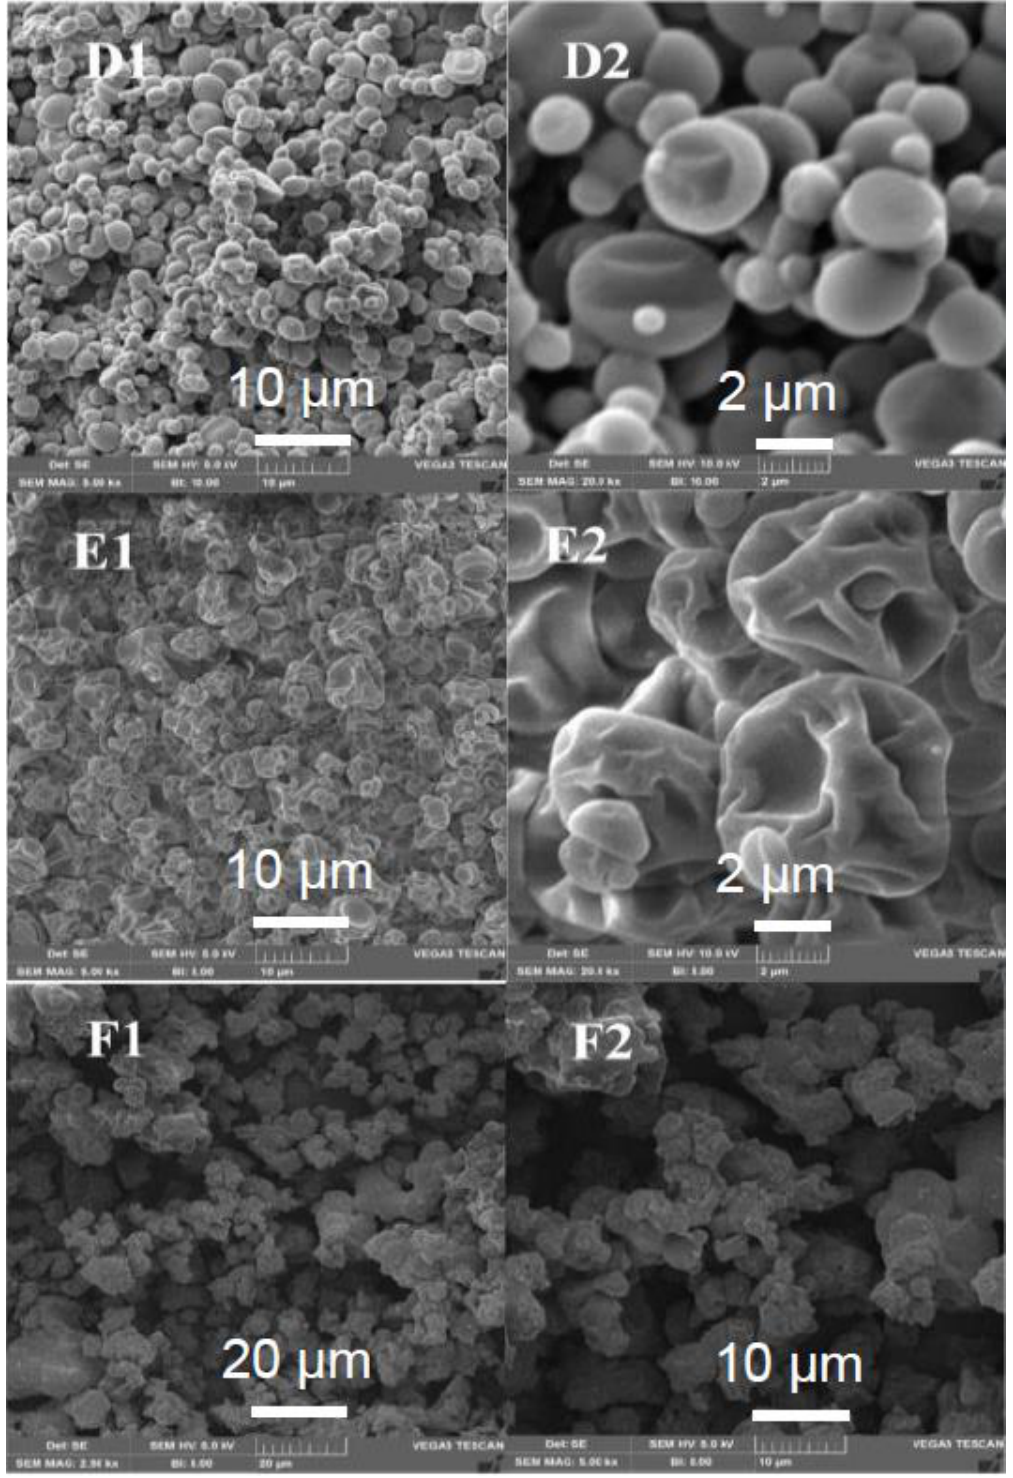
Figure 2. Scanning electron photomicrographs of the powders formed in the spray drying of the enzymatic extract with the carriers: maltodextrin ( D1 , D2 ), gum arabic ( E1 , E2 ) and mannitol ( F1 , F2 ). D1, E1, and F2: 5.0 kX magnification; F1: 2.5 kX magnification; D2 and E2: 20.0 kX magnification. The powder recovery yield (Y) ranged widely according to the carrier type (Table 1). The best results of Y were obtained with soluble starch (59.13%), followed by corn starch (40.22%) and cassava starch (29.67%). Yields in this range (20 to 60%) are considered com- mon for laboratory-scale spray dryers [45–47]. Yields below 15% were obtained with the